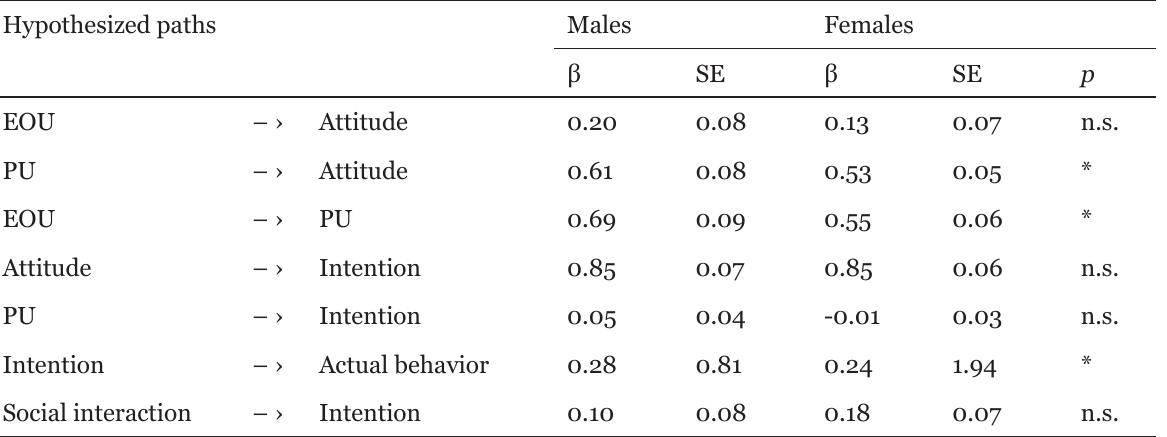
Moderation Analysis Results Hypothesized